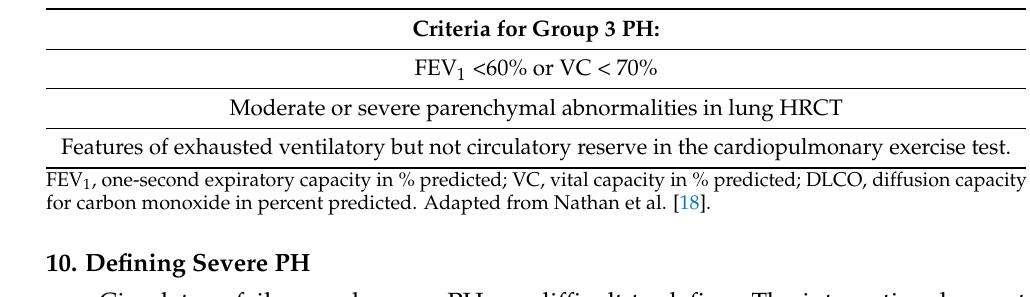
Table 1. Criteria for Group 3 PH.